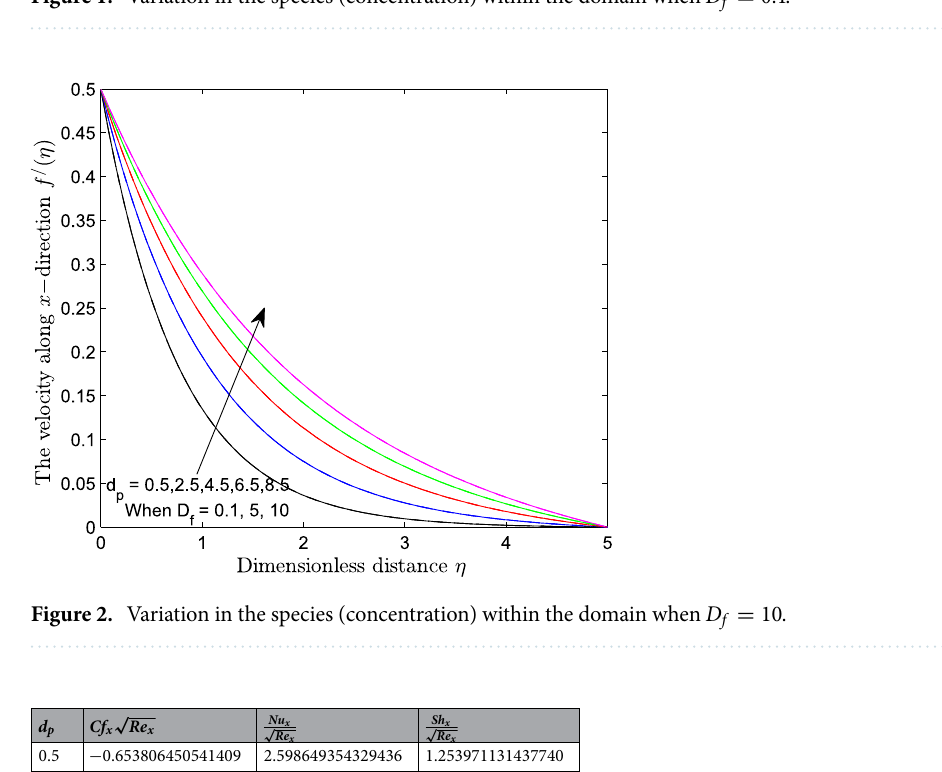
Figure 1. Variation in the species (concentration) within the domain when D f